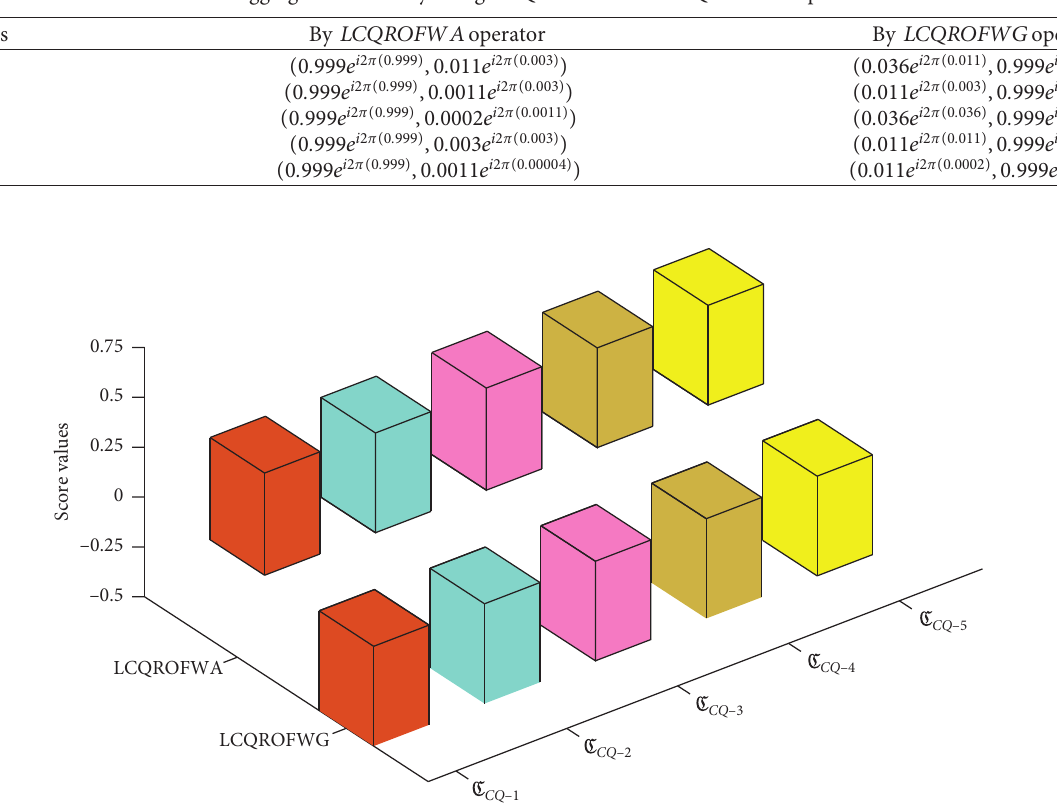
Table 2: Aggregated values by using LCQROFWA and LCQROFWG operators.